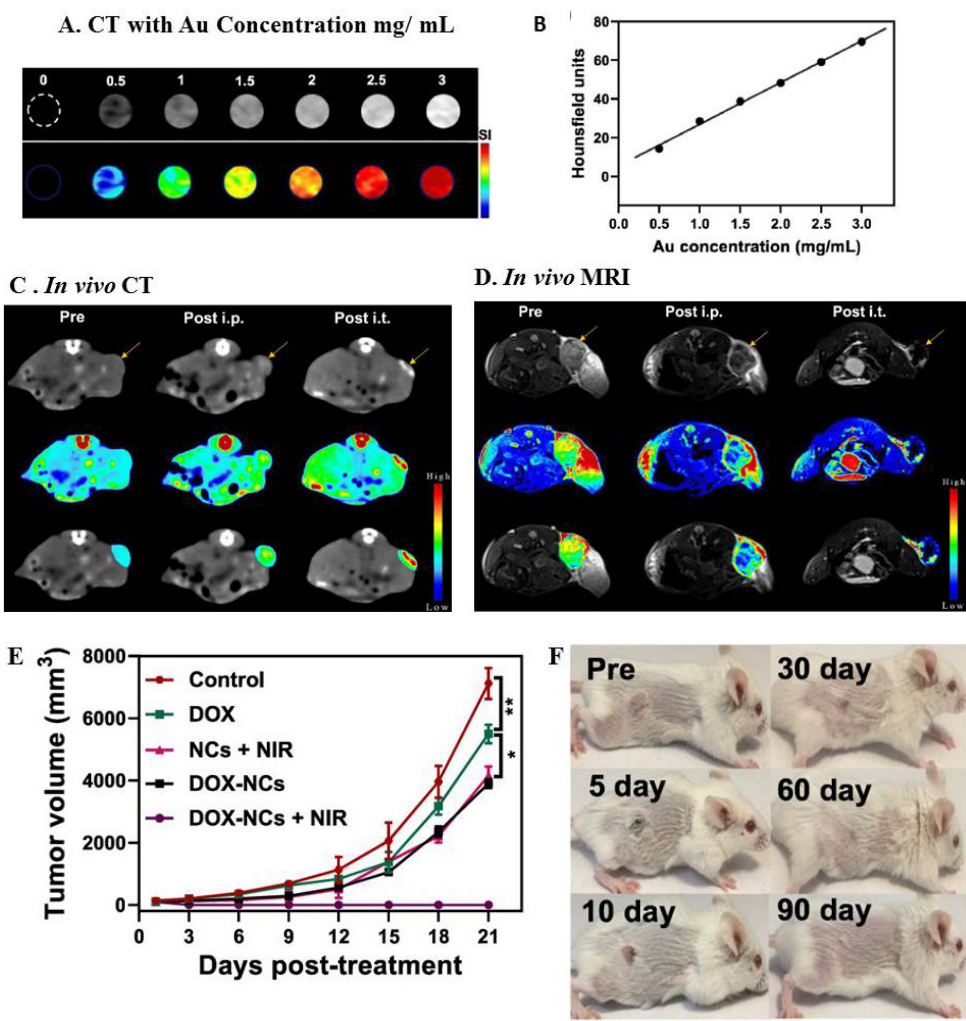
Figure 7. In vivo CT and MR imaging of NCs containing AuNPs and SPIOs. ( A ) CT images of CNs with increasing concentration of AuNPs from 0–3 mg/mL. ( B ) The corresponding graph of Hounsfield values with AuNPs concentration. In vivo ( C ) CT scan and ( D ) MR images of CT26 tumor bearing mice, pre and post injections at post i.p and post i.t. The upper, middle, and lower images are for original, intensity mapping, and merged images of all. ( E ) Corresponding results after PT where the graph shows reduction in tumor volume within few days of time with DOX-NCs+NIR. ( F ) The morphology of tumor and total mice view from pre injection to 90 days of therapy. The stars (*) represents the statistical significance of the data (* for 0.05, ** for 0.01). Reprinted/adapted with permission from Ref. [119]. Copy right 2022, copyright Ivyspring.